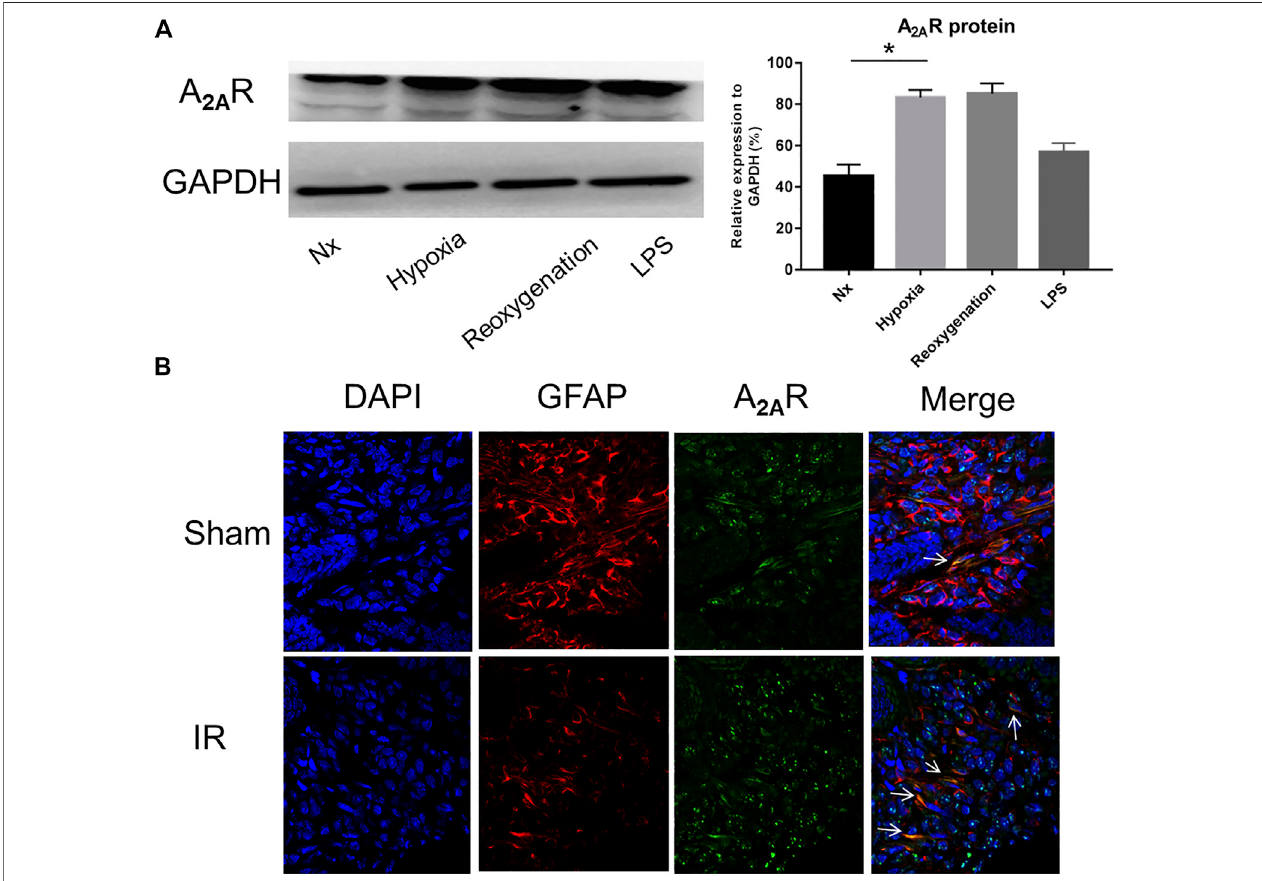
FIGURE1| ExpressionofA 2A Rinenteric glial cells(EGCs)underhypoxiastimulation. (A) Western blot analysisshows asigni fi cantincrease ofA 2A R protein level in cultured EGC cells after hypoxia and reoxygenation treatment. GAPDH was used as a standard for cellular protein input. (B) Immuno fl uorescence was used to detect A 2A R expression in the small intestineunder IR treatment. Red and green signals represent GFAP and A 2A R, respectively. Resultsare expressed as mean ± SD ( n (cid:2) 4 – 6 mice/group) (* p < 0.05).